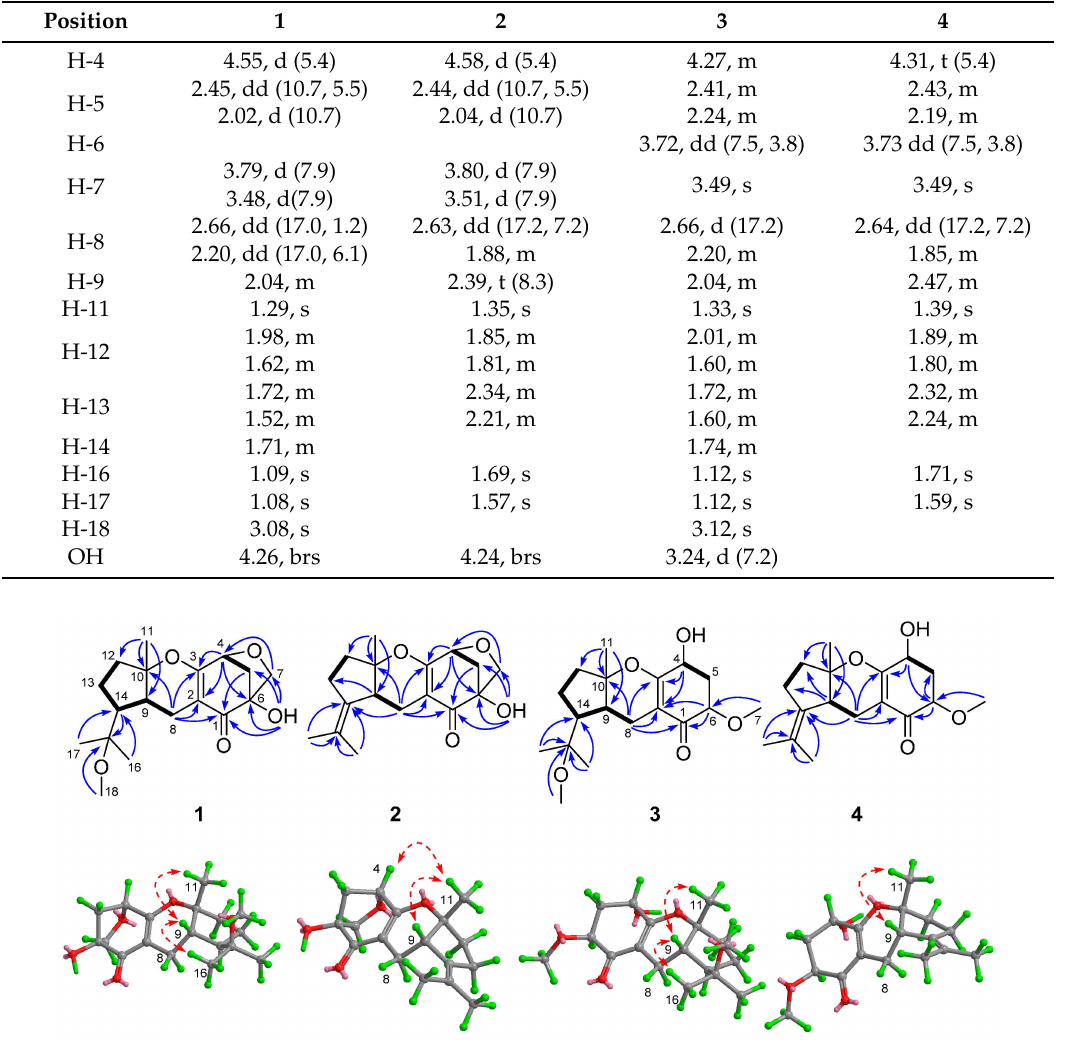
Table 1. 1 H-NMR data of 1 − 4 in CDCl 3 at 500 MHz ( J in Hz, δ in ppm).